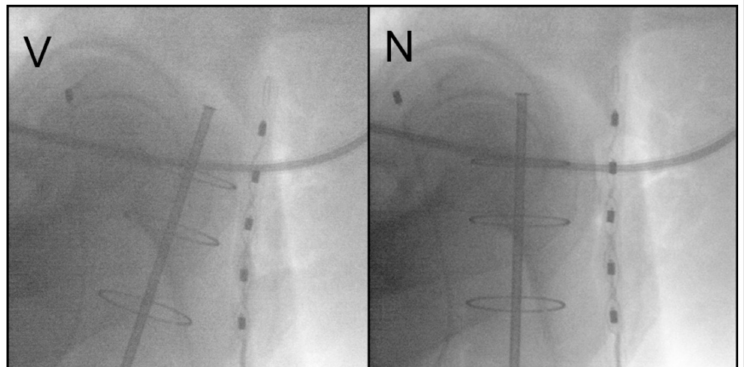
Figure 2. Lateral pre-interventional X-ray, before (V) and after (N) correction of the applicator position with consecutive reduction in the applied rectal